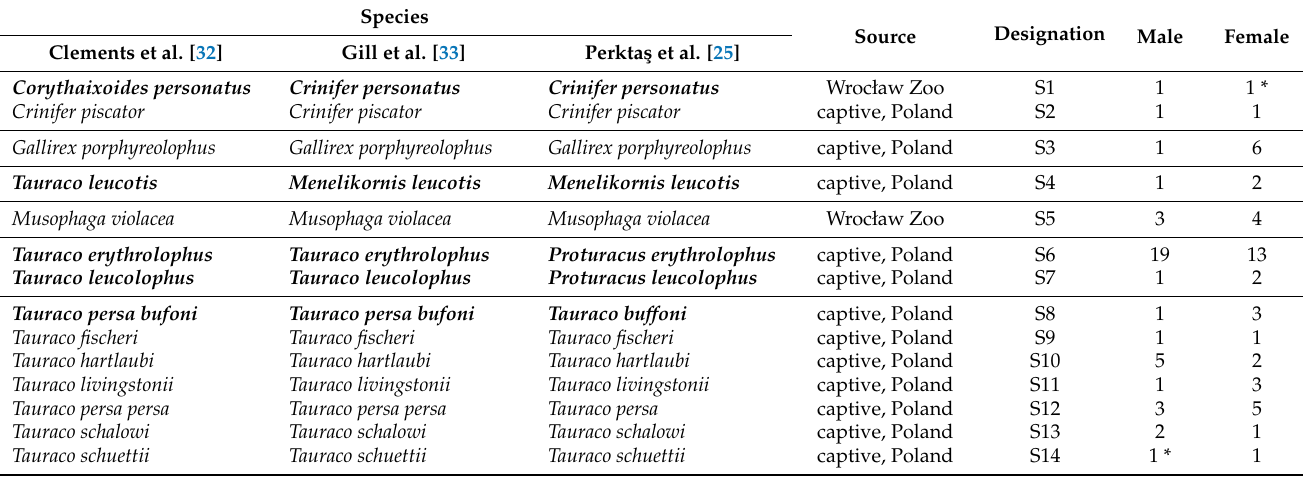
Table 1. Turaco species used in the reported research.